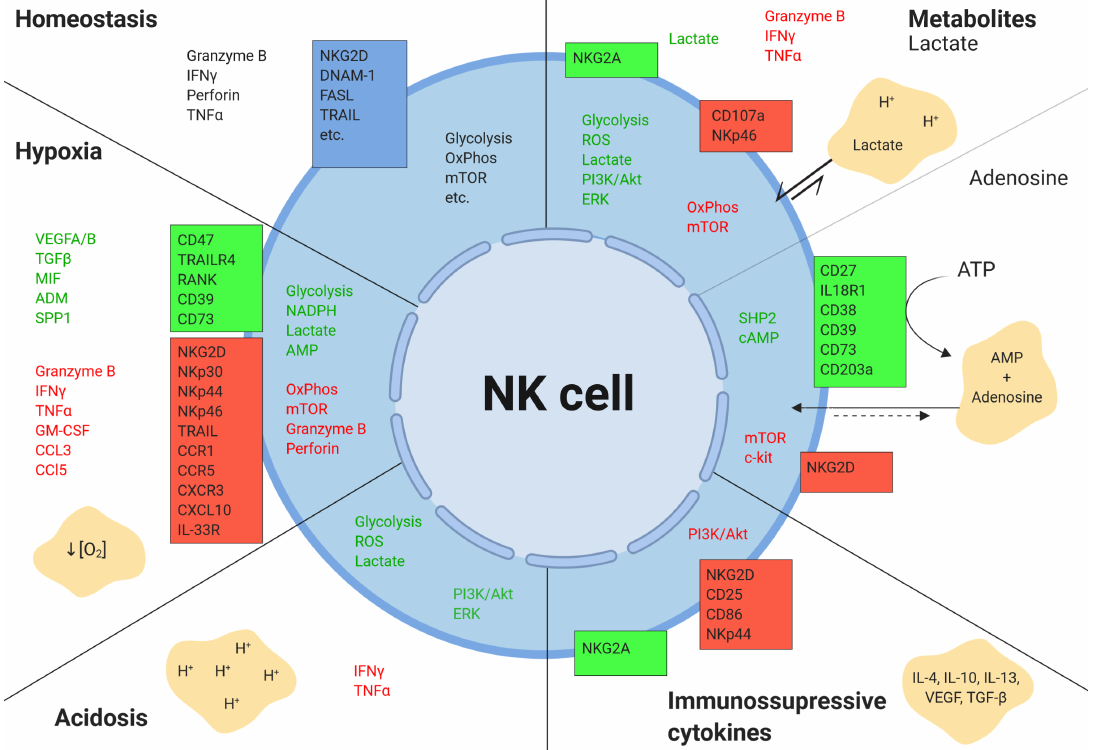
Figure 4. Effects of the tumor microenvironment on NK cells.The tumor microenvironment alters the expression of various secreted, surface, and intracellular molecules in NK cells. Boxes represent surface receptors. Green indicates upregulation, and red depicts downregulation. Figure created with